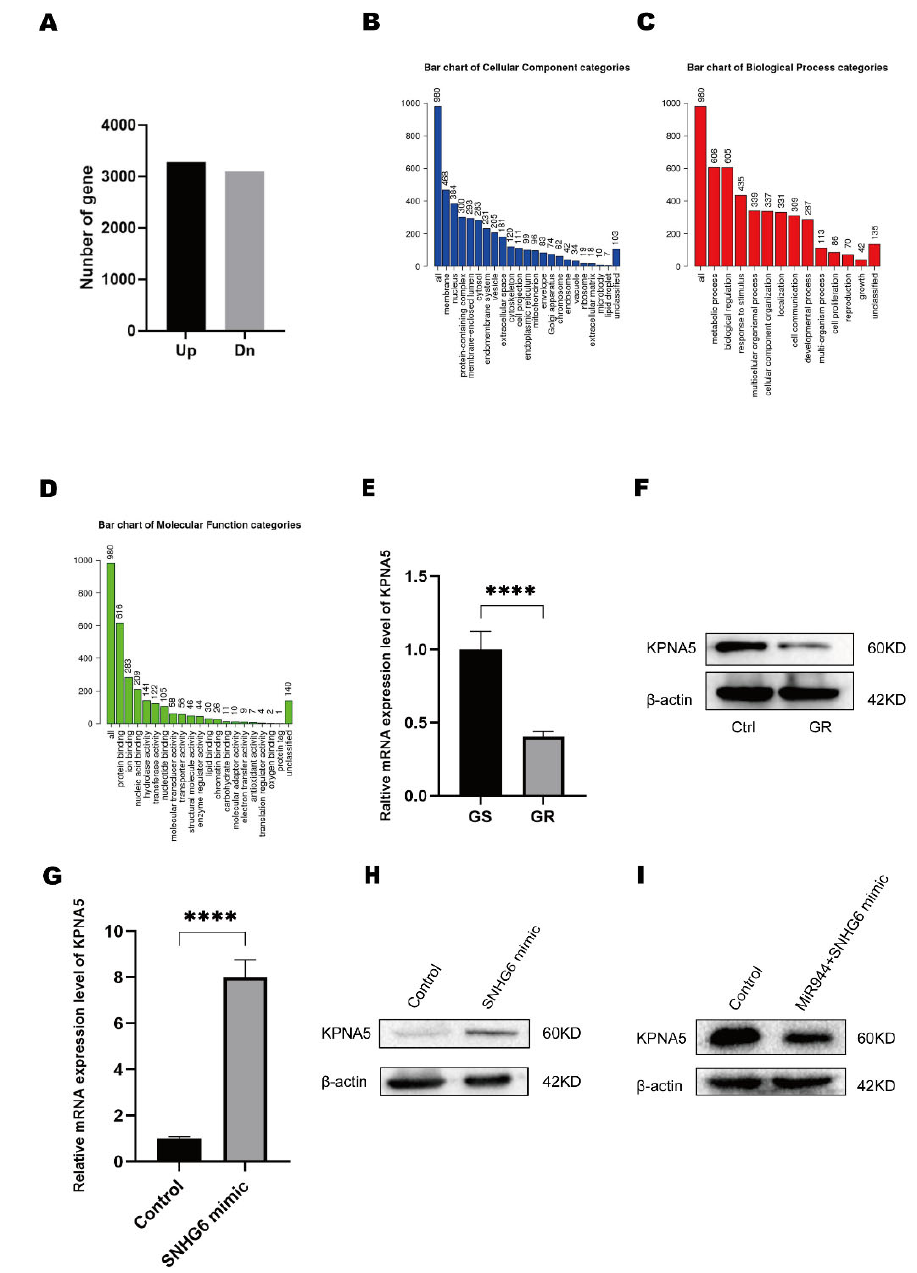
Figure 4. LncRNA SNHG6 regulates the expression of KPNA5 in PC. ( A ) Histogram of gene expression detected by RNA CHIP measurement after LncRNA SNHG6 overexpression in PANC-1 cells. ( B ) Enrichment of categories of cellular components in which the upregulated genes were enriched and analyzed by the online toolkit WebGestalt. ( C ) Histogram of categories of a biological process in which the upregulated genes were enriched by WebGestalt. ( D ) Histogram of categories of molecular function in which the upregulated genes were enriched by WebGestalt. ( E ) PCR analysis of KPNA5 levels in GEM-sensitive (GS) and GEM-resistant (GR) PANC-1 cells, n = 3, ****, p < 0.0001. ( F ) Western blotting analysis of KPNA5 expression in GEM-sensitive (Ctrl) and GEM-resistant (GR) PANC-1 cells. ( G ) PCR analysis of KPNA5 levels in PCNC-1 cells transfected with LncRNA SNHG6 mimic or control, n = 3, ****, p < 0.0001. ( H ) Western blotting analysis of KPNA5 expression in PCNC-1 cells transfected with LncRNA SNHG6 mimic or control. ( I ) Western blotting analysis of KPNA5 expression in PCNC-1 cells co-transfected with LncRNA SNHG6 mimic and miR-944 or